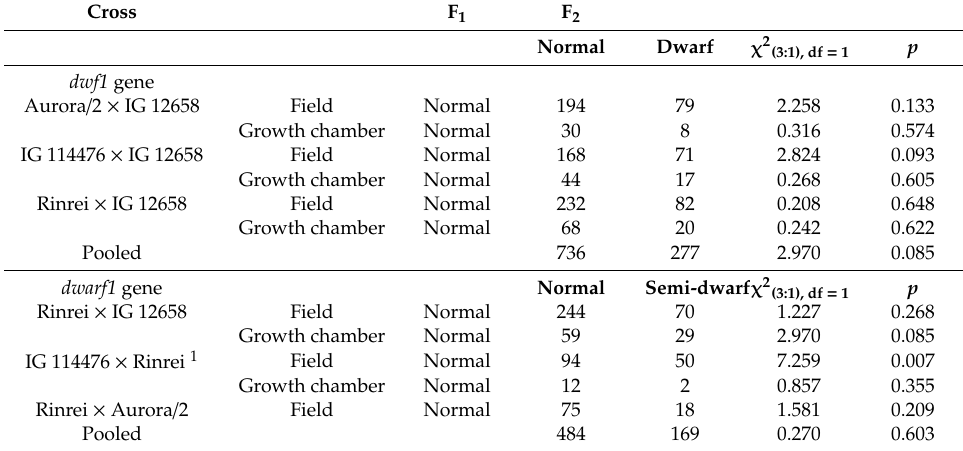
Table 2. Observed o ff spring segregation ratios, value of χ 2 test, and the corresponding p -value for normal-height and ( dwf1 and dwarf1 genes) phenotypes for F 1 and F 2 generations of faba bean crosses. Cross F 1 F